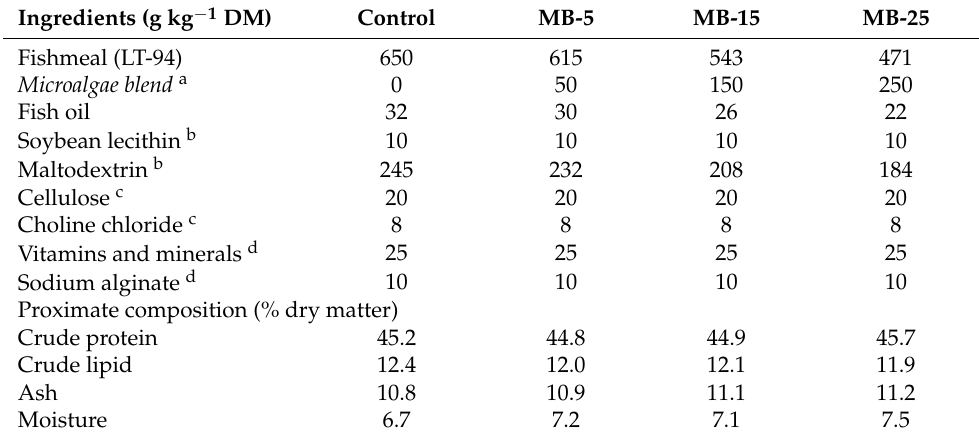
Table 1. Ingredient composition and nutrient composition of experimental